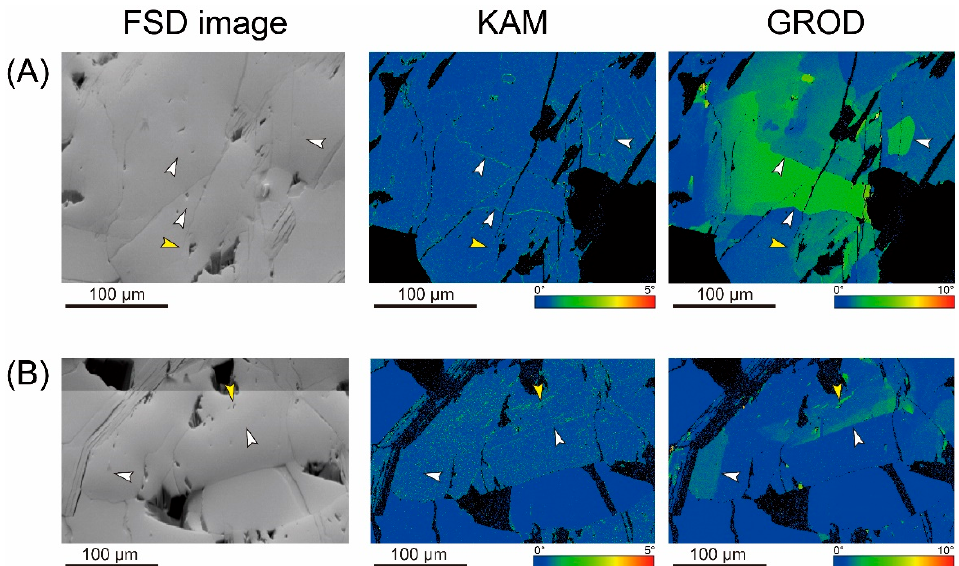
Figure 5. Internal misorientation maps in tremolite grains from the tremolite-rich layer of sample 443. Forward scatter detector (FSD) image, kernel average misorientation (KAM) map, and grain reference orientation deviation (GROD) map are illustrated for two areas ( A ) and ( B ). The KAM ranges from 0 ◦ to 5 ◦ , and the GROD ranges from 0 ◦ to 10 ◦ . White arrows mark the location of potential subgrain boundaries in tremolite grains. Yellow arrows mark the intracrystalline misorientation associated with a crack or fracture.